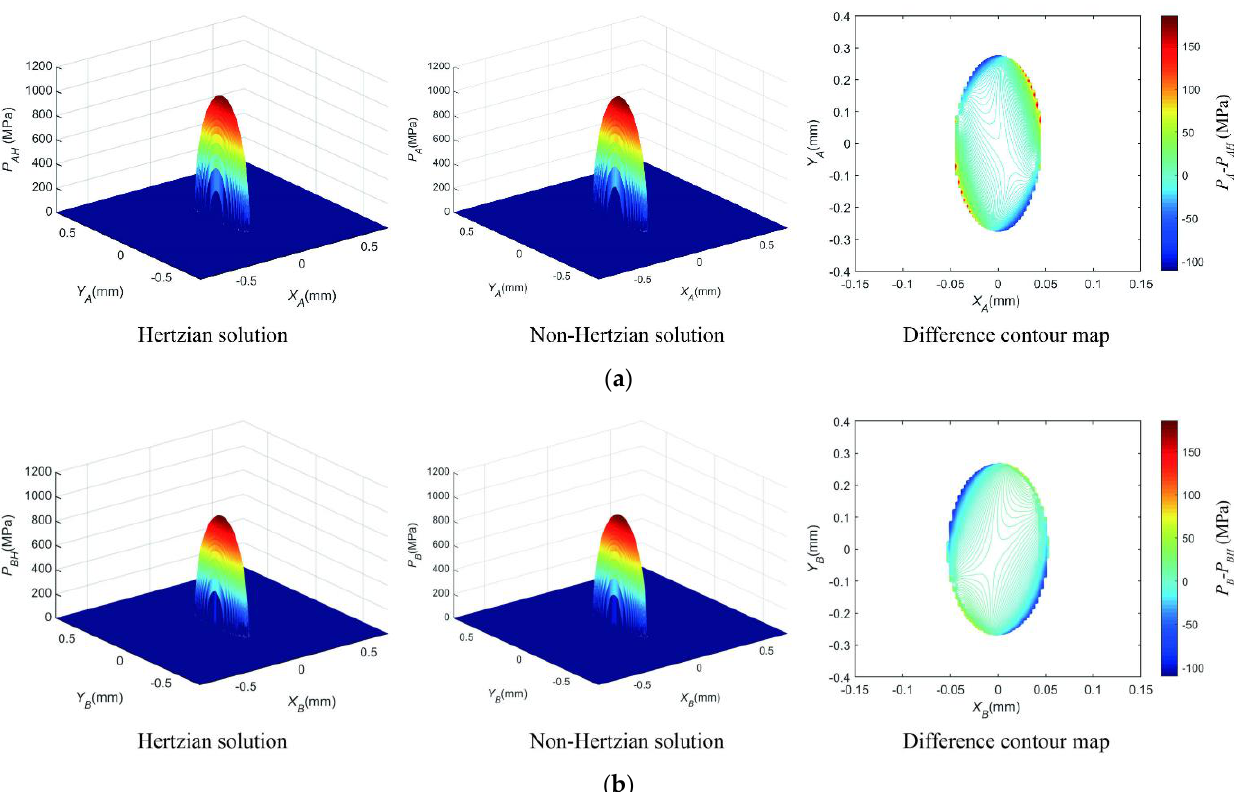
Figure 7. The contact stress distribution comparison between the Hertzian solution and the non-Hertzian solution. ( a ) Contact stress solution at the ball/screw – raceway point A . ( b ) Contact stress solution at the ball/nut raceway point B .